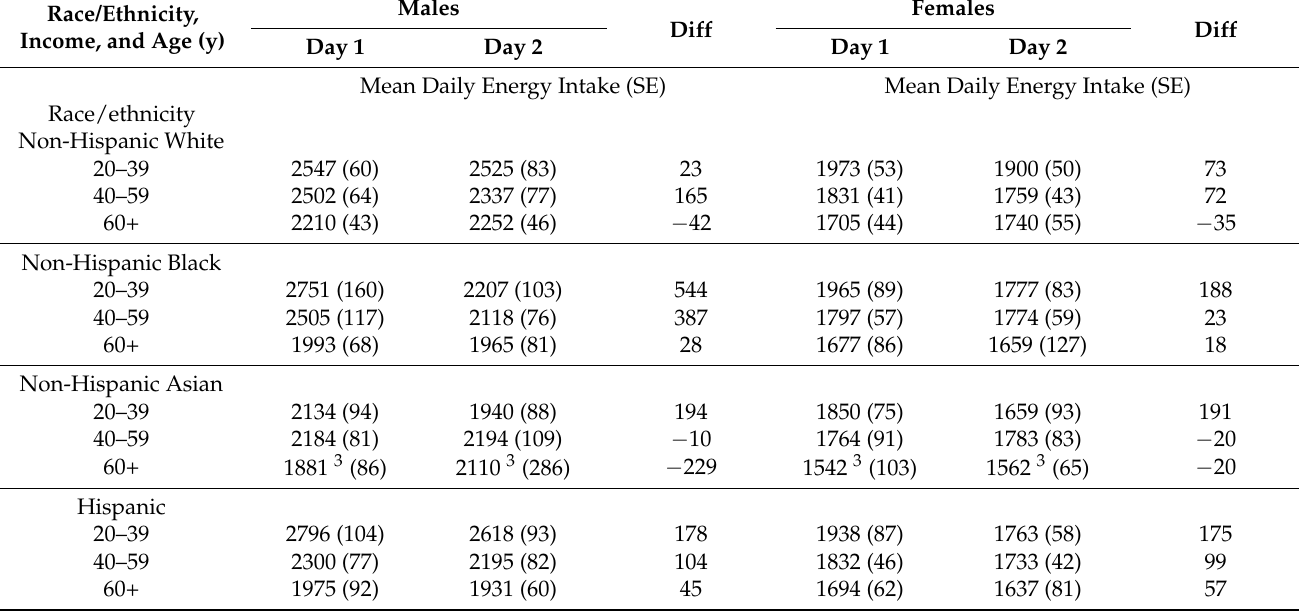
Table 5 provides the mean daily energy intake by sociodemographic characteristics, sex, age, and intake day. There were no significant differences in mean daily energy intake between days by race/ethnicity or income at the predetermined level of p < 0.001. The difference in energy intake between Day 1 and Day 2 for the different ethnicities among males ranged from − 229 kcal for NH Asians age 60 plus to 544 kcal for NH Blacks age 20–39 years, and among females ranged from − 35 kcal for NH Whites age 60 plus to 191 kcal for NH Asians age 20–39 years. These differences in energy intake between Day 1 and Day 2 correspond to 2–20% of Day 1 mean energy intake. The difference in energy intake between Day 1 and Day 2 for the different income levels among males ranged from − 36 kcal for 131–350% PIR age 40–59 years to 265 kcal for <131% PIR age 40–59 years, and among females ranged from − 61 kcal for 131–350% PIR age 60 plus to 156 kcal for <131% PIR age 20–39 years. These differences in energy intake between Day 1 and Day 2 correspond to 4–11% of Day 1 mean energy intake. Table 5. Mean daily energy intake by sociodemographic characteristics, sex, age, and intake day for U.S. adults age 20+, WWEIA, NHANES 2013–2016 1 . Race/Ethnicity, Income, and Age (y) Race/ethnicity Non-Hispanic White